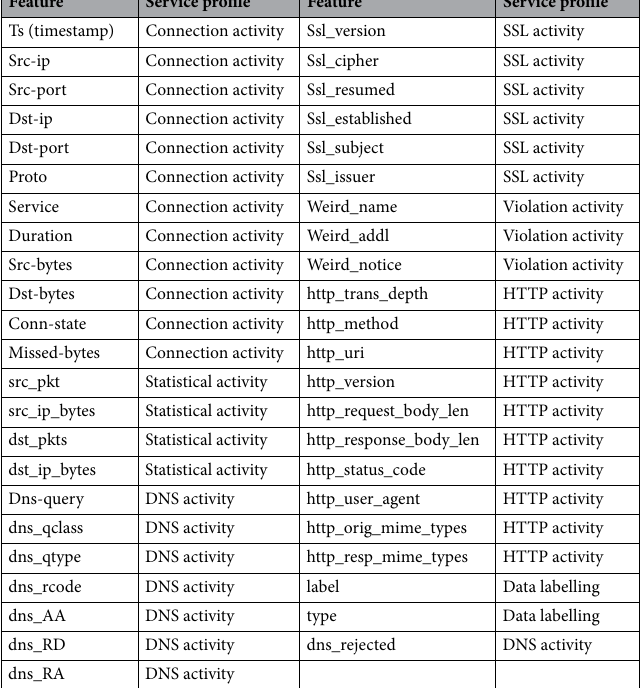
Table 2. Features of TON datasets.